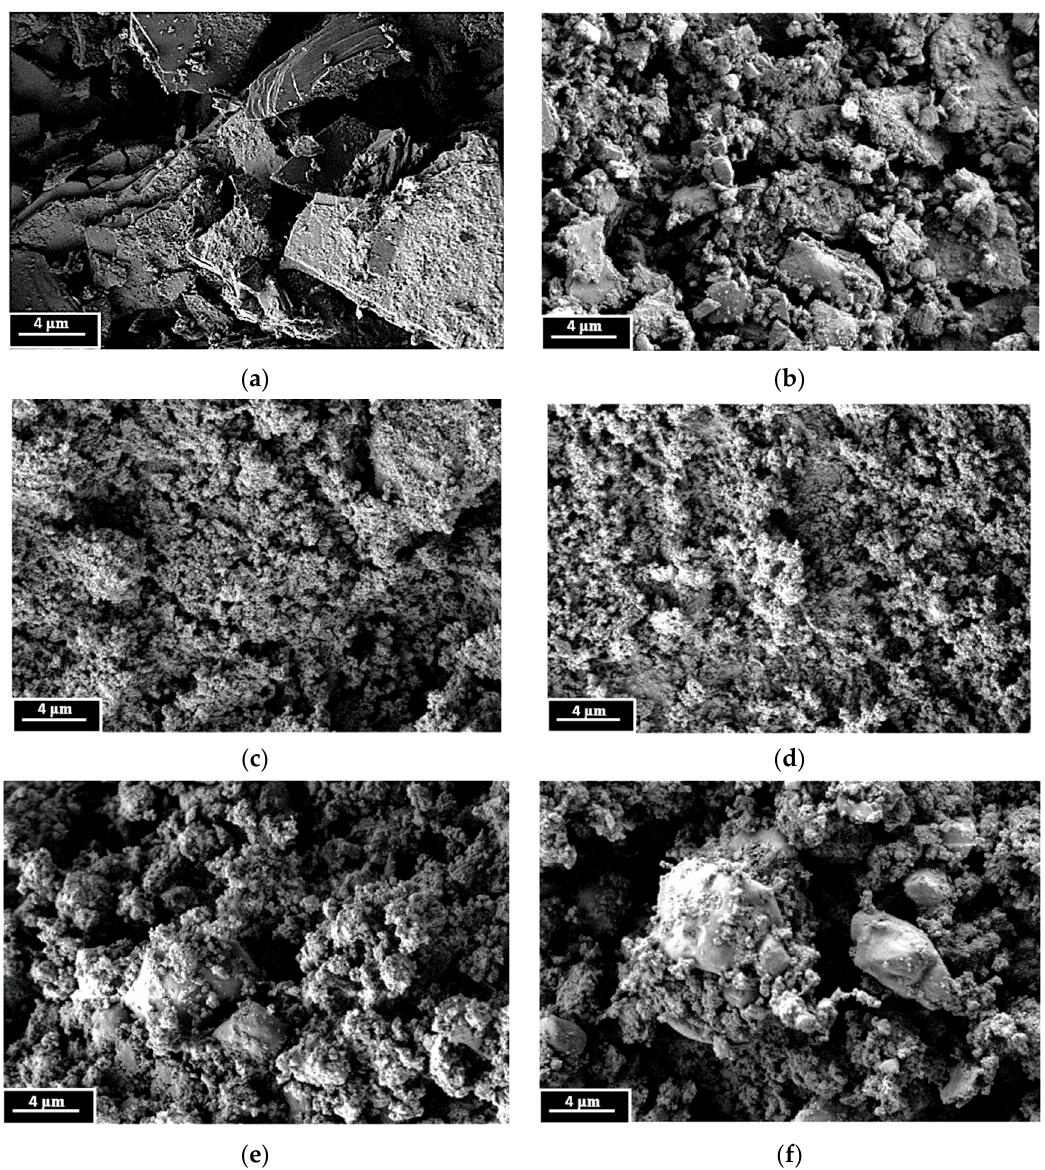
Figure 2. SEM images of powder samples CaP ( a , b ), CaPSi ( c , d ) and CaSi ( e , f ) after synthesis ( a , c , e ) and disaggregation in acetone ( b , d , f ).